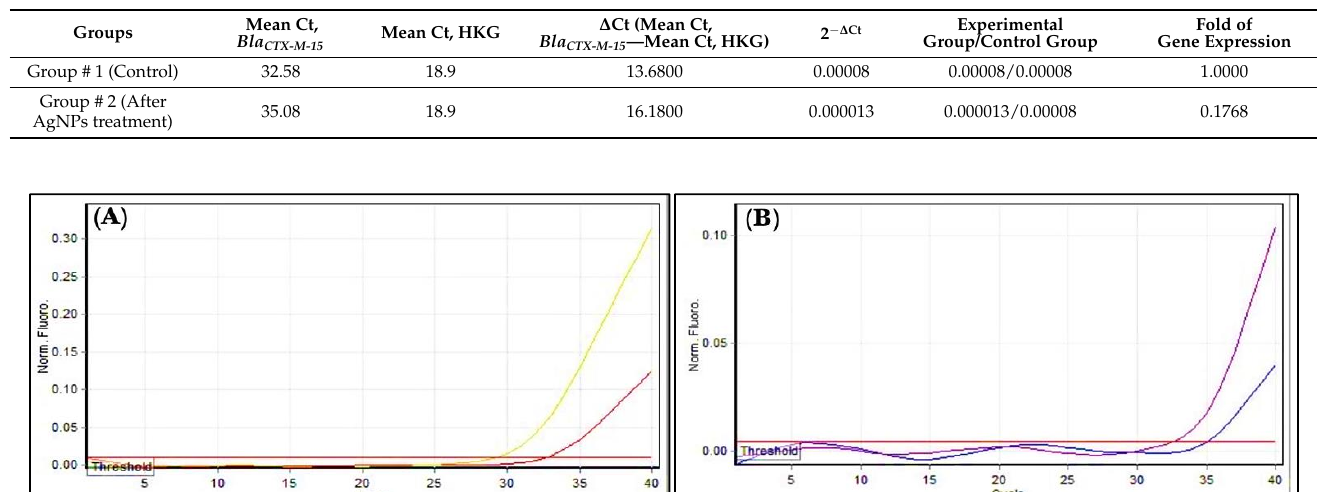
Figure 15. Gene expressions: ( A ) Bla gene; ( B ) Bla CTX-M-15 . Amplification plots by qPCR samples before and after treatment with AgNPs. The picture was taken directly from the Cepheid (smart cycler) qPCR.